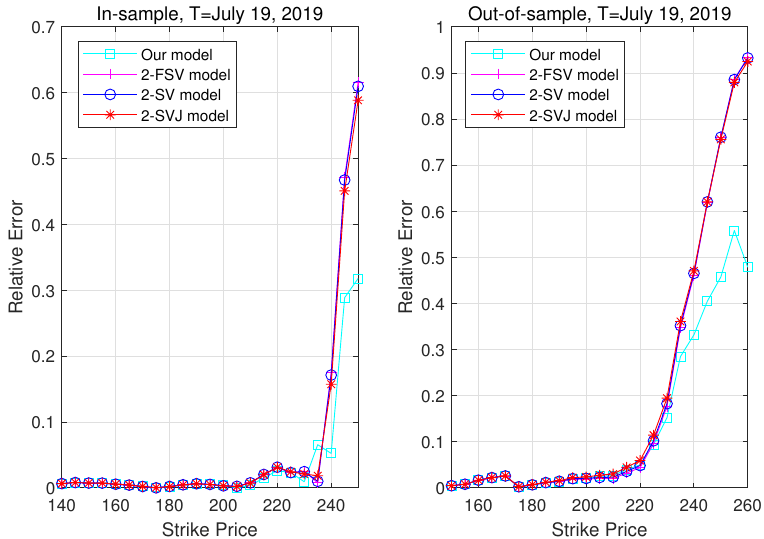
Figure 6. The comparison of predicted prices of four model specifications and market prices on 9 May 2019, with maturity T = 19 July 2019.